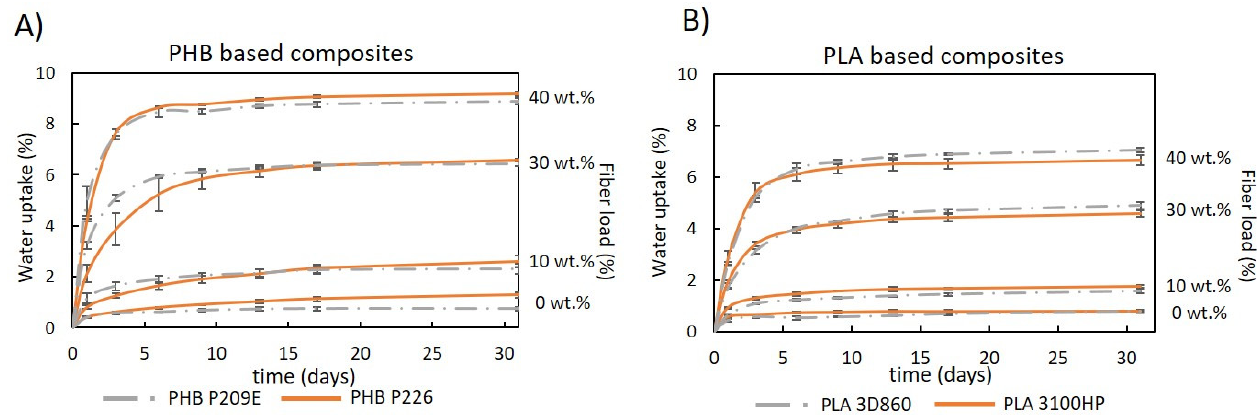
Figure 8. Water uptake as function of time for: ( A ) PHB- and ( B ) PLA-based composites reinforced with Cel355.